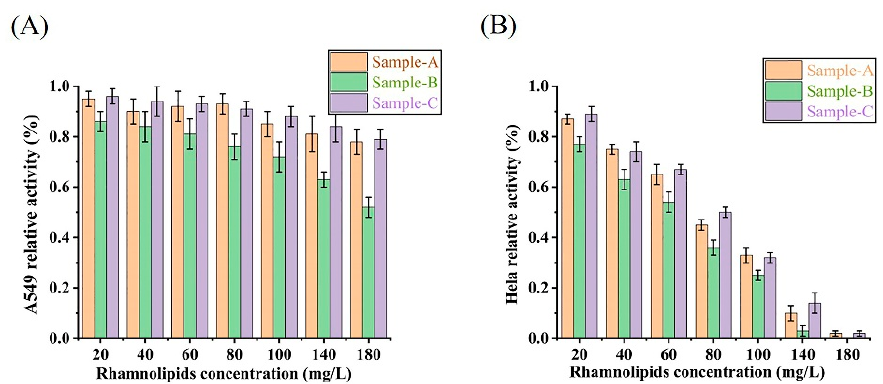
Figure 6. The effects of rhamnolipid Sample A, Sample B and Sample C on cell viability of A549 ( A ) and Hela cells ( B